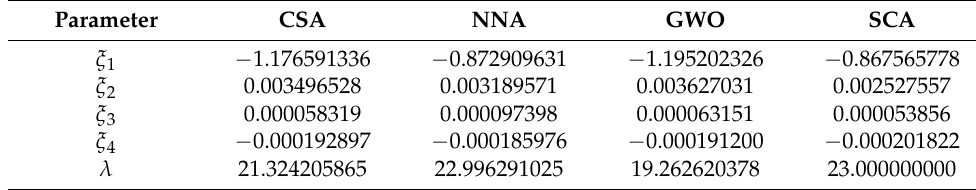
Figure 9. Convergence curve of fitness function for BCS fuel cell. Table 3. Optimal parameters of BCS PEMFC model.